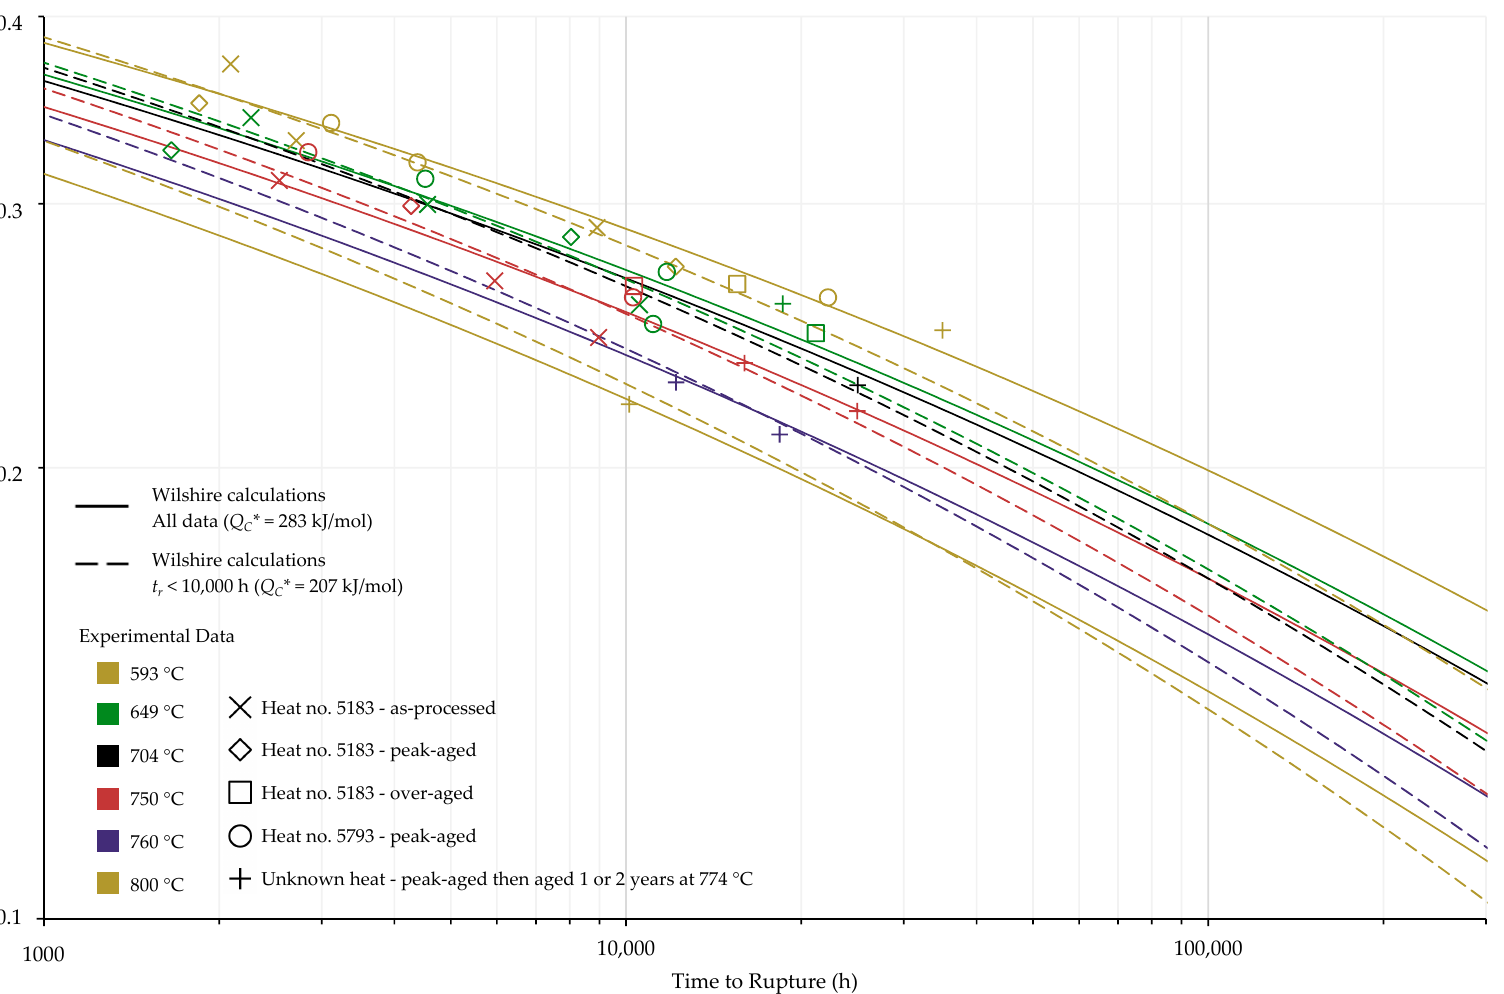
Figure A17. Split region calculations of the Wilshire equation for Nimonic 105 using heat ‐ and processing ‐ specific tensile strength values with (cid:1843) (cid:3004)∗ determined using Arrhenius plots.